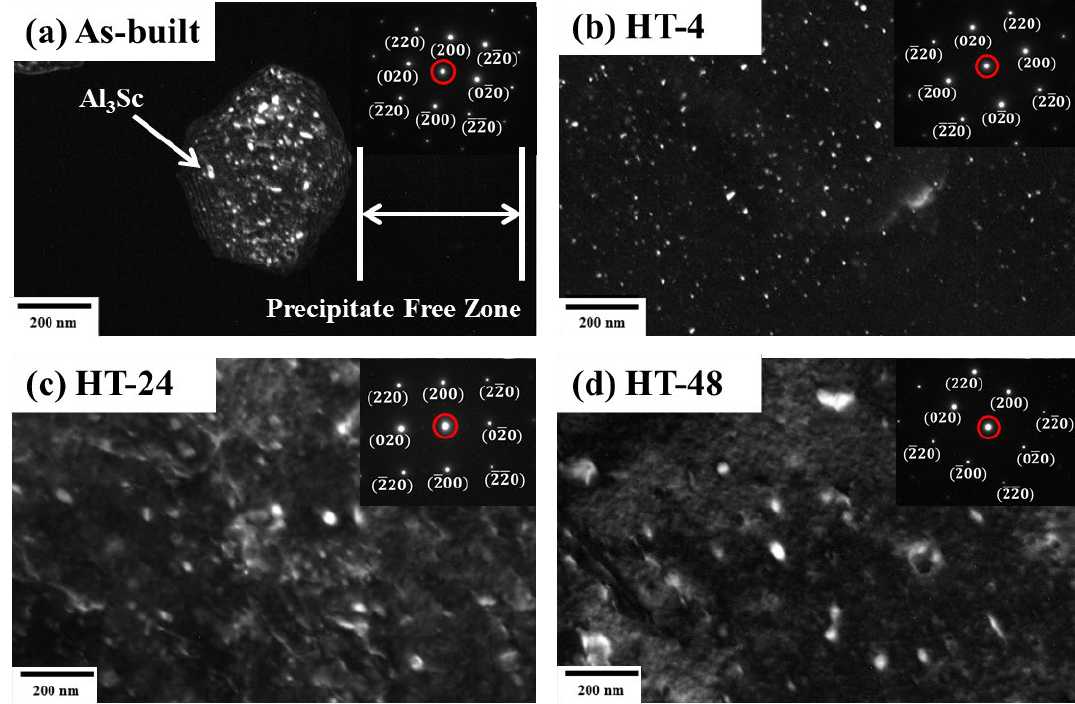
Figure 6. TEM images and the corresponding selected area diffraction pattern (SADP) of ( a ) the as-built sample, ( b ) heat-treated sample at 325 ◦ C for 4 h, ( c ) sample heat-treated at 325 ◦ C for 24 h, and ( d ) heat-treated sample at 325 ◦ C for 48 h. The aperture for dark field imaging is indicated by the red circle in SADP. Table 3. Summary of Al 3 Sc precipitation size and volume fraction of the as-built and heat-treated samples Scalmalloy samples.